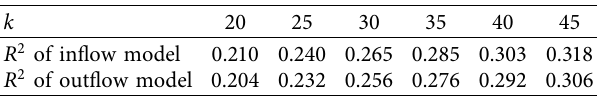
Figure 5: Average capacity utilization rate of bicycle-sharing in different time periods in different urban areas. Table 6: The number of randomly selected variables ( k ) and the goodness of fit (R2) of